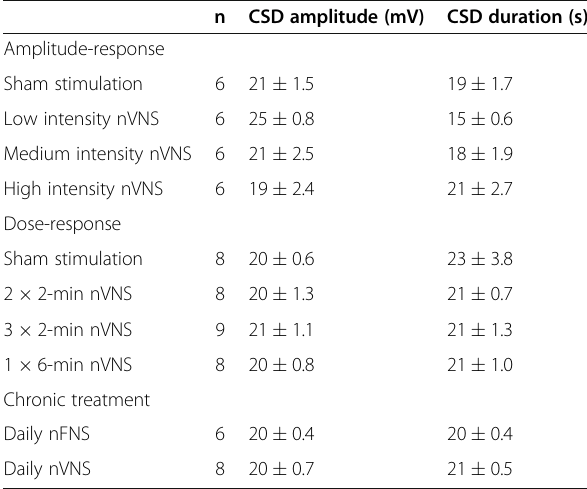
Table 2 Amplitude and duration of CSD in different nVNS paradigms